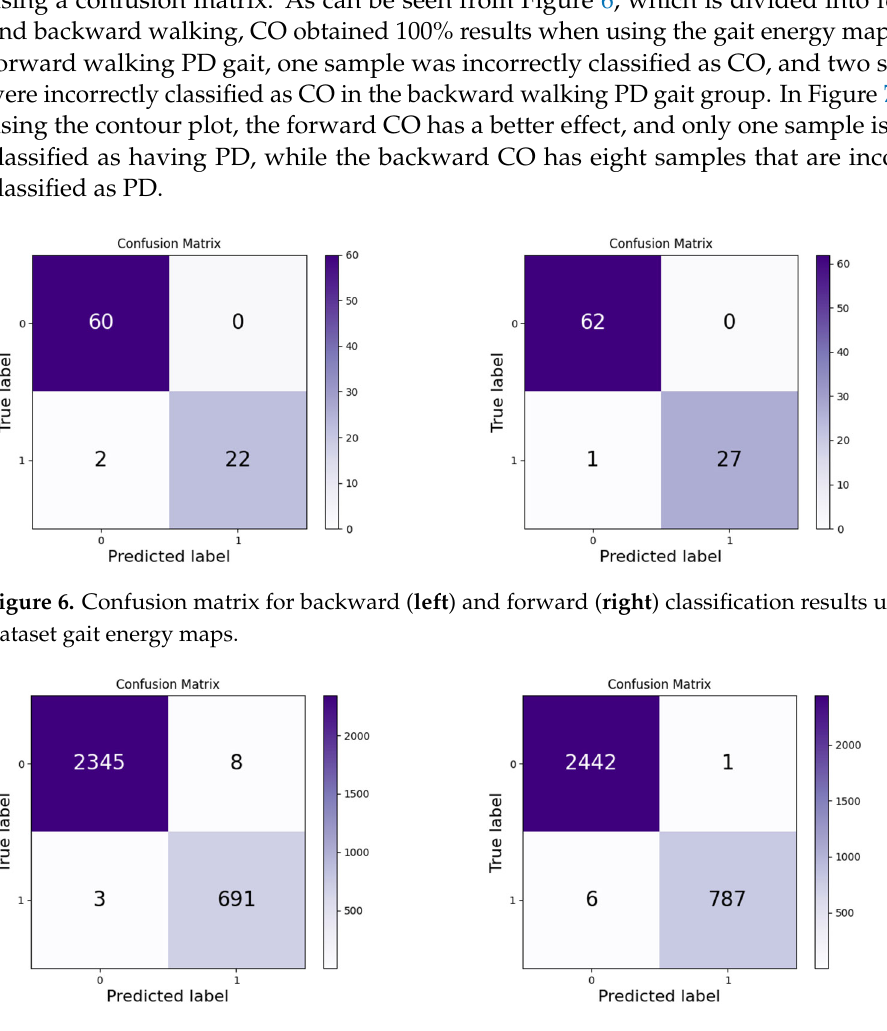
Table 3. Results on gait silhouette maps using the GAIT ‐ IST dataset.